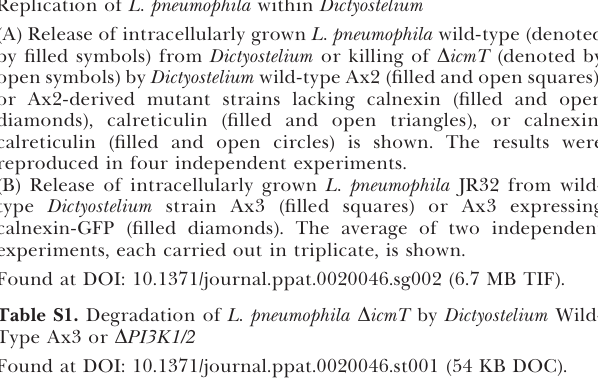
Figure S2. Calnexin or Calreticulin Do Not Affect Intracellular Replication of L. pneumophila within Dictyostelium